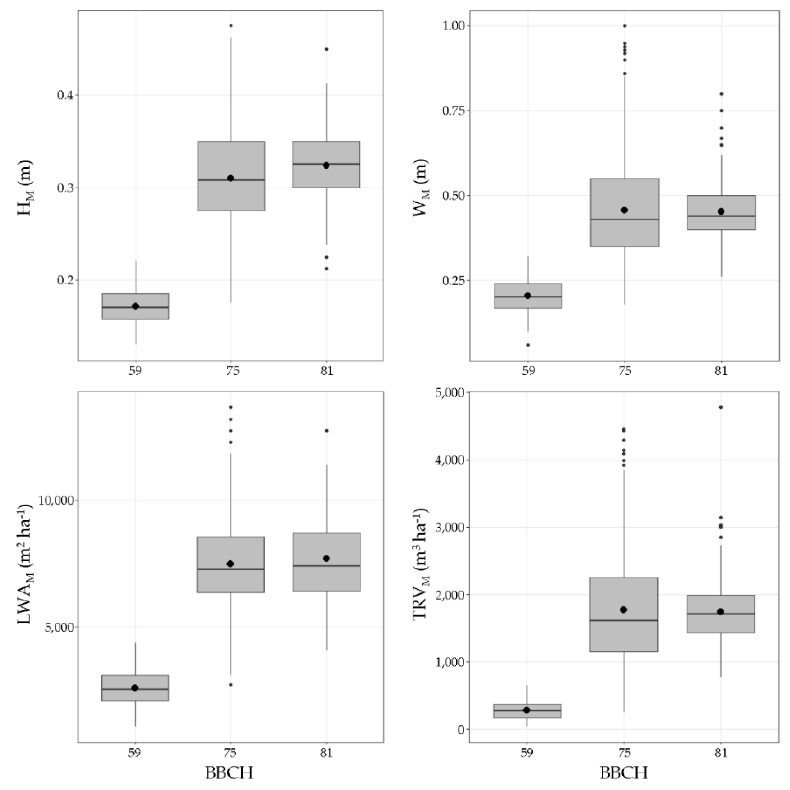
Figure 5. Box plots of principal descriptive statistical parameters for manual measurements. ● mean values.